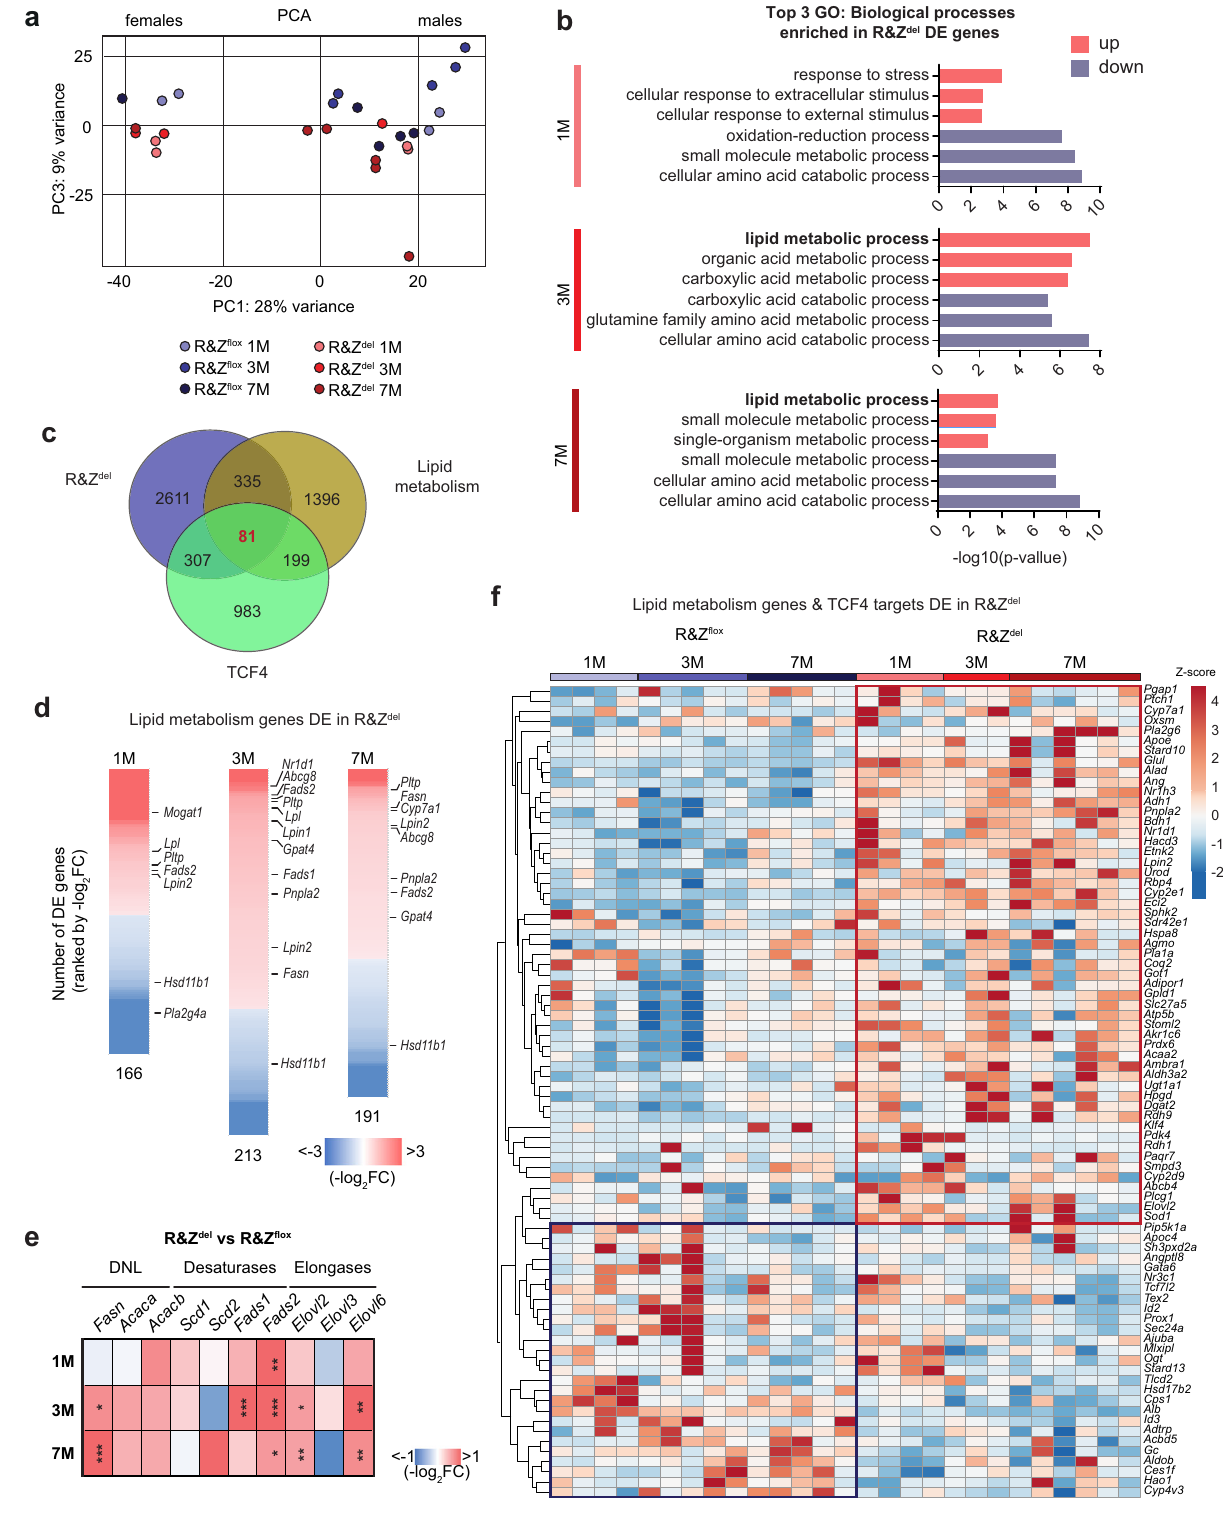
tended to contain a 20:4-fatty acyl chain. Since the rate-limiting step for in vivo generation of 20:4 is the desaturation of 18:2 by FADS2 enzyme, we determined the “ Fads2 index ” , as a proxy for FADS2 activity. For that, we calculated the ratio of {PC(36:4)[16:0/ 20:4] + PC(38:4)[18:0/20:4]} to {PC(34:2)[16:0/18:2] + PC(36:2) [18:0/18:2]} and found this to be signi fi cantly increased in the Rnf43/Znrf3 del mice, compared to their respective controls. NATURE COMMUNICATIONS| (2022) 13:334